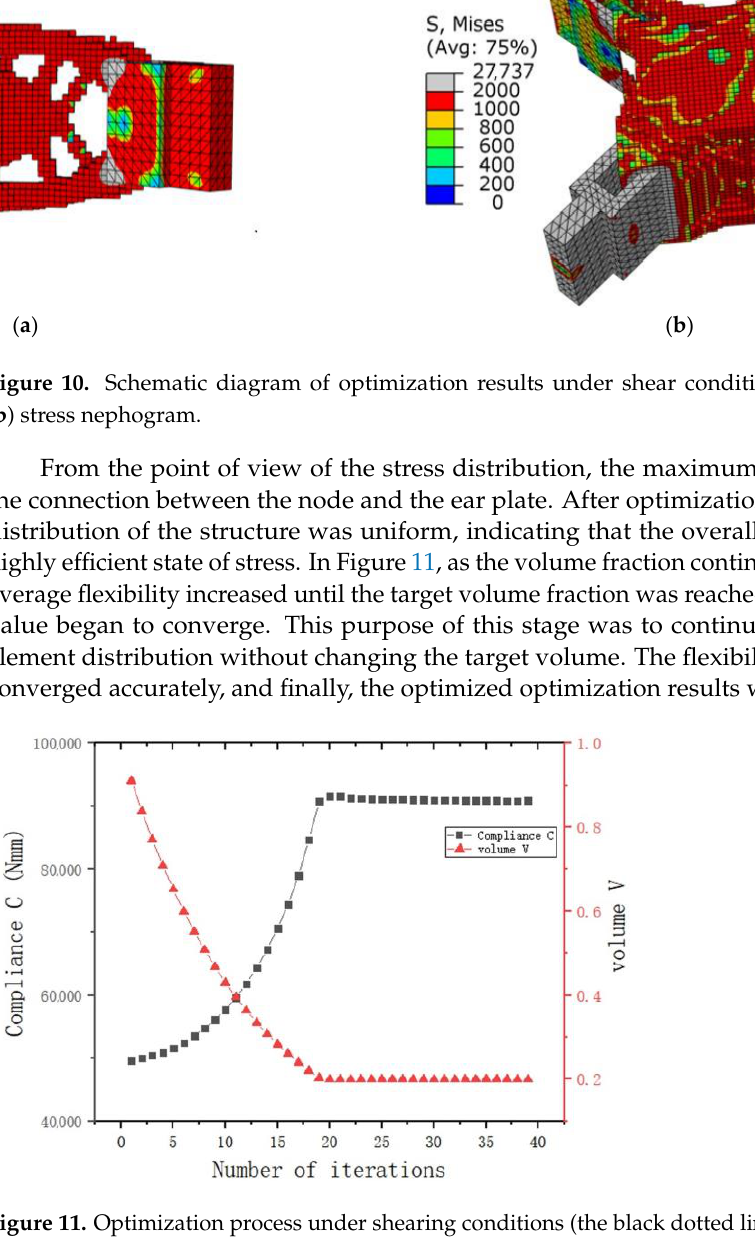
( b ) Figure 12. Schematic diagram of optimization results under combined conditions: ( a ) cutaway view; ( b ) stress nephogram.